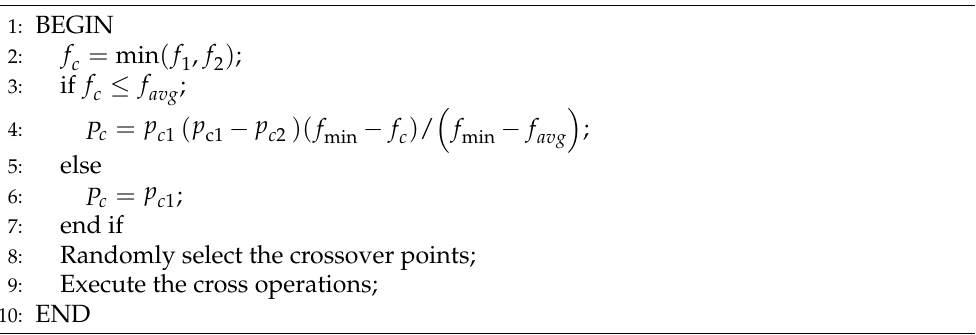
Algorithm 2 Single-point crossover algorithm for task offloading position.